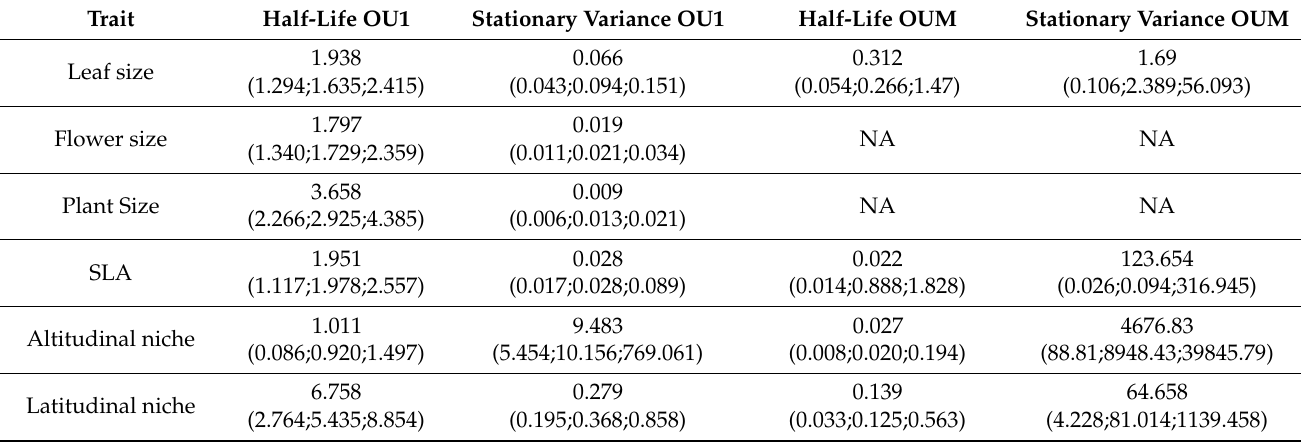
Table 4. Phylogenetic half-life and stationary variance of the 6 traits considered in the study estimated under the evolutionary model OU1 and OUM if for a particular trait an OUM model obtained the best fit. For leaf size, the OUM is the OUM Clade. For SLA and altitudinal niche, the OUM is the OUM Regime. For the latitudinal niche, the OUM is the OUM Geo. The values displayed are estimated from the MCC tree together within parenthesis the 10%, 50% and 90% quantiles of the distribution of ∆ AICc estimated from the posterior distribution of trees (100 trees). The phylogenetic half-life (t 1/2 = ln2/ α ) is the time in millions of years (Ma) taken for an OU process to erase half the phylogenetic covariance between sister taxa. A half-life equal to the age of the MRCA of a clade (here, 7.2 Ma) indicates a phylogenetic signal equivalent to the expectation under a BM model of evolution (strong signal), whereas a half-life smaller than the age of the youngest node in a clade (here 0.36 Ma) indicates no phylogenetic correlations (no signal). The stationary variance ( V y = σ /2* α ) quantifies the relative strength of drift and directional selection around an adaptive